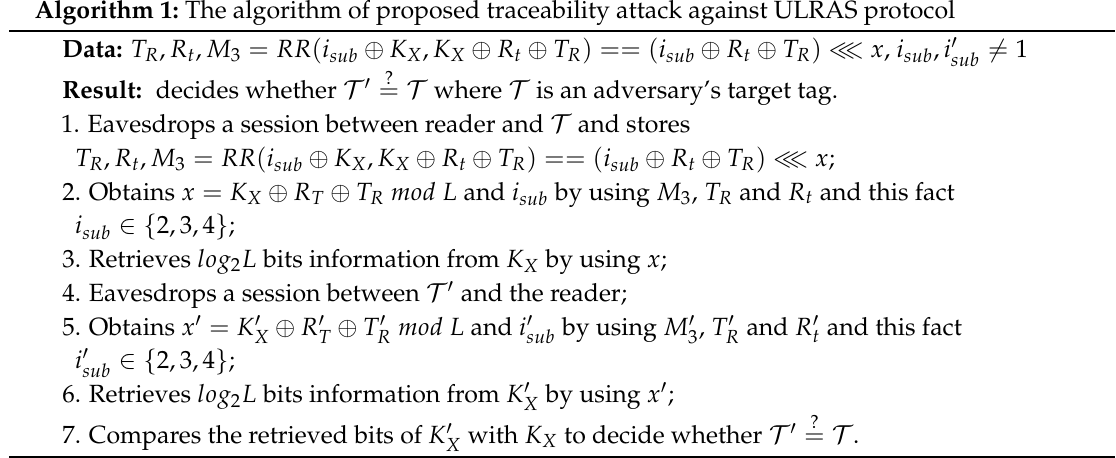
Algorithm 1: The algorithm of proposed traceability attack against ULRAS